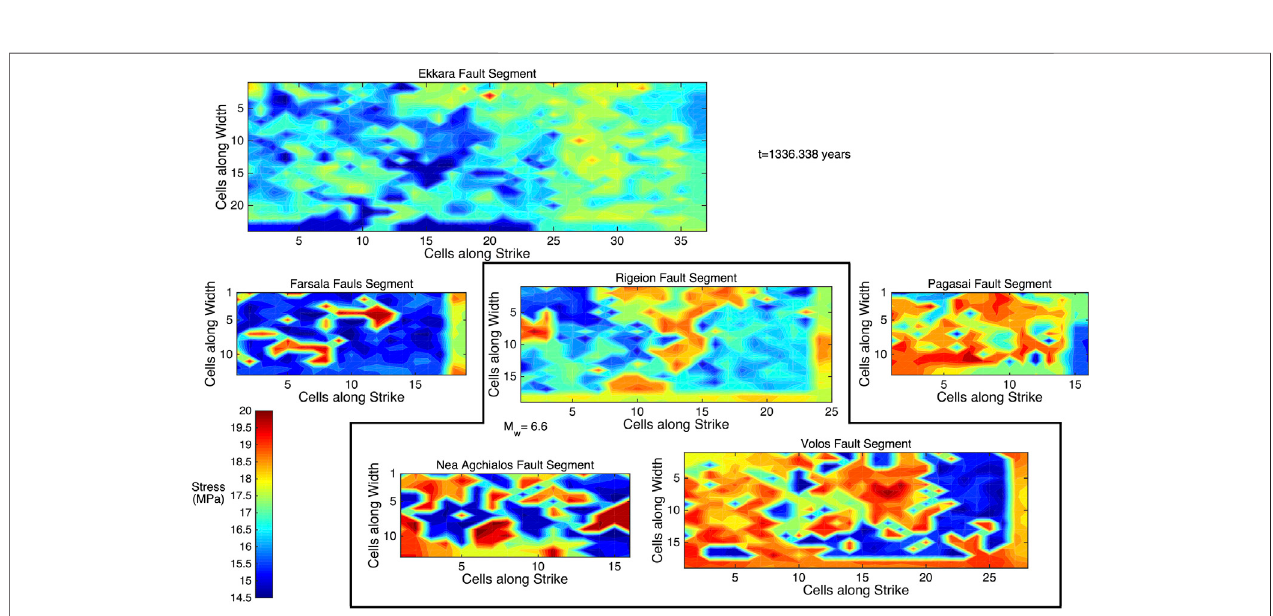
FIGURE 8 | The state of stress (in MPa) in the six fault segments of STFZ at time t (cid:1) 1,336.338 years, when the Rigeion, Nea Agchialos, and Volos fault segments ruptures simultaneously (black polygon), resulting in a M w (cid:1) 6.6 earthquake. The stress value on each cell is depicted with the color bar, ranging from 14.5 MPa (dark blue) to 20 MPa (dark